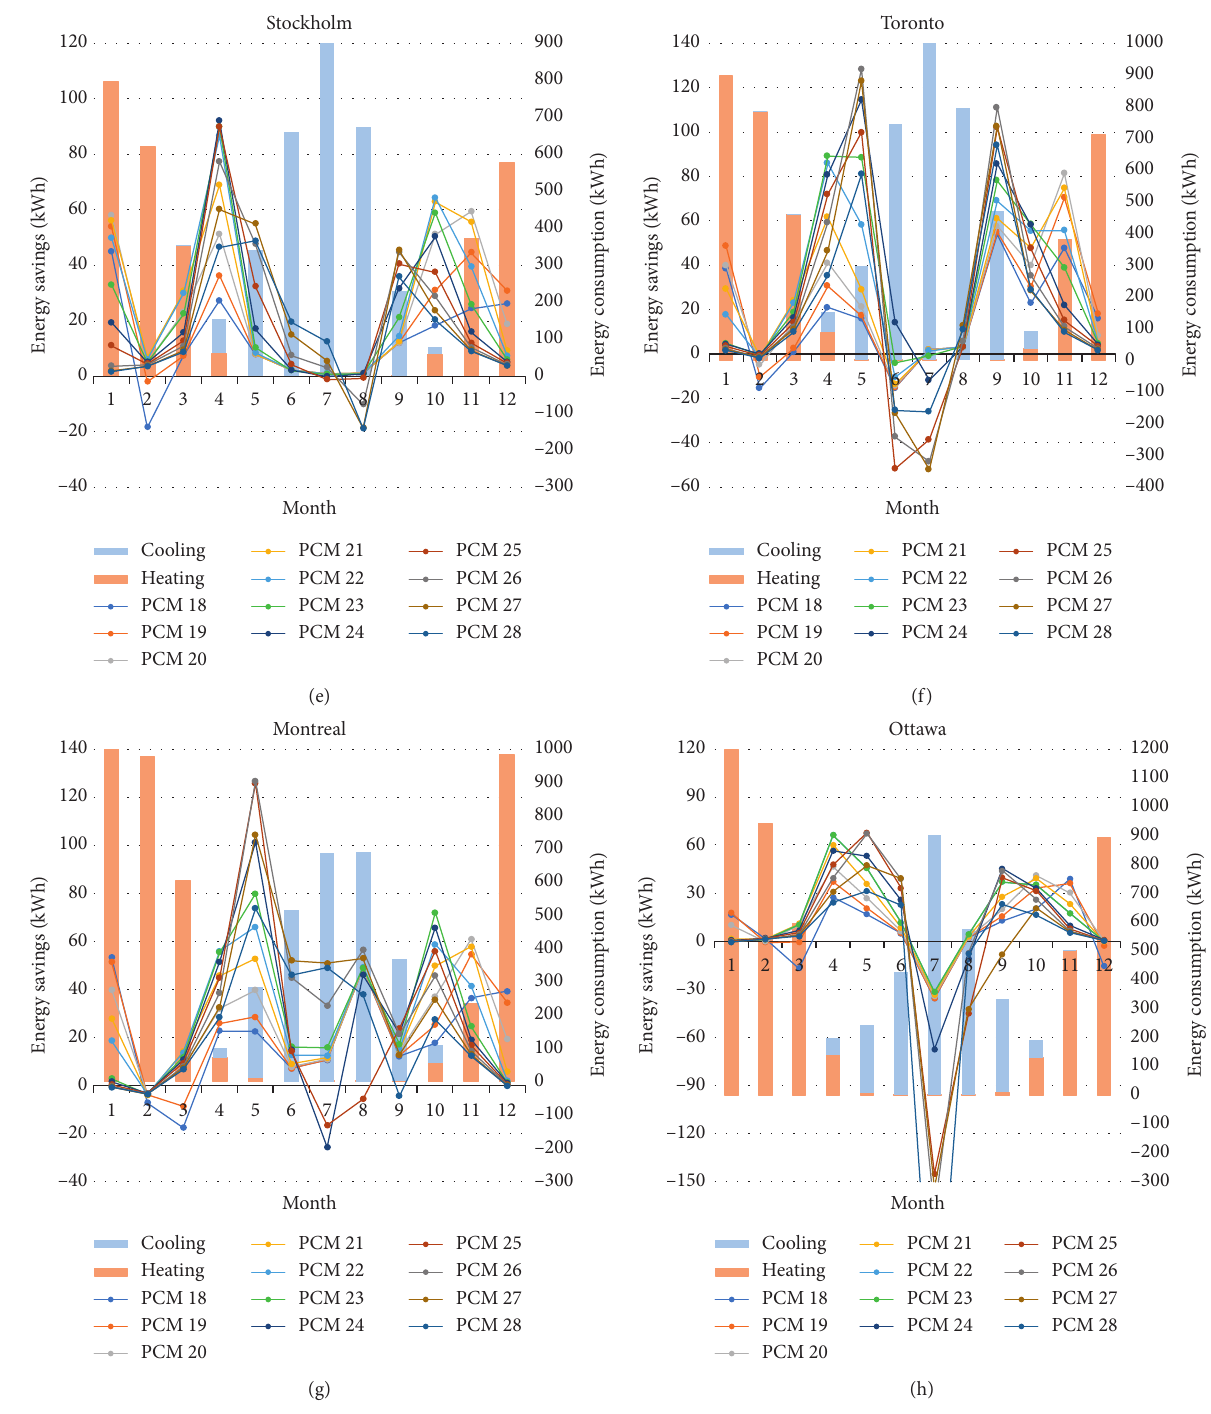
Figure 7: Monthly energy consumption and savings results for all PCMs in eight